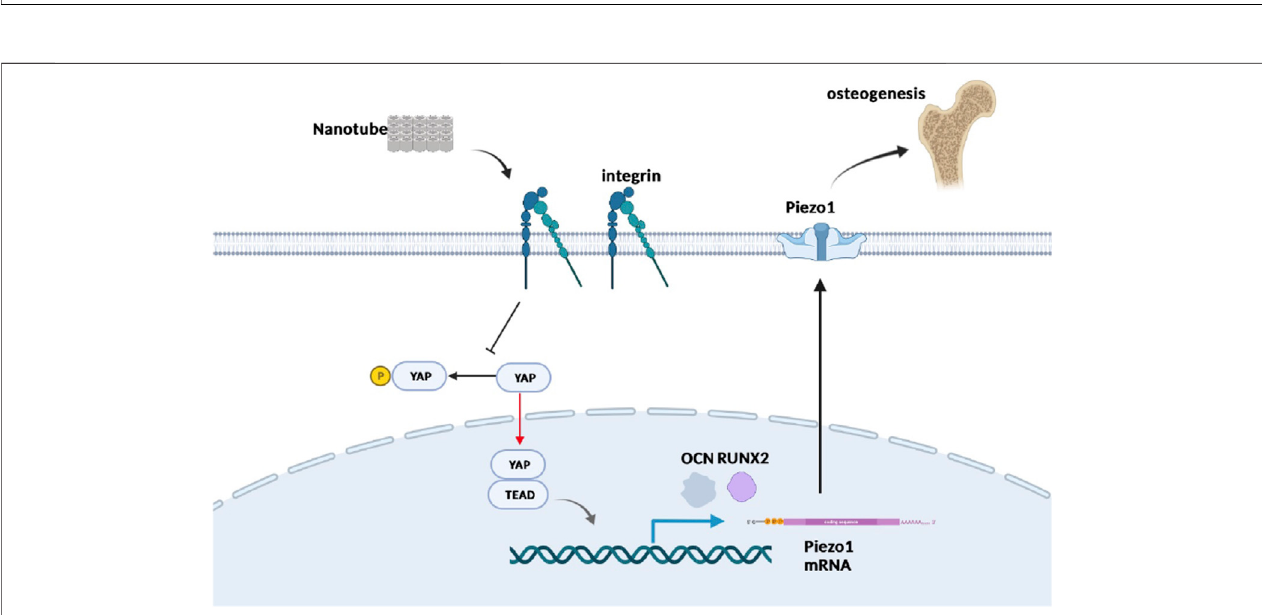
FIGURE 7 | Schematic plot to illustrate the role of Yap and Piezo1 in promoting nanotube-related osteogenesis. Nanotopography is recognized by mechanosensors such asintegrinsresiding in thecellmembrane, which suppresses theHippo pathway and promotes nuclear entryofYap.Furthermore, Yapactivates TEADs and enhances the expression of Piezo1, which has been proved to be signi fi cant in osteogenesis. Created in BioRender.com.